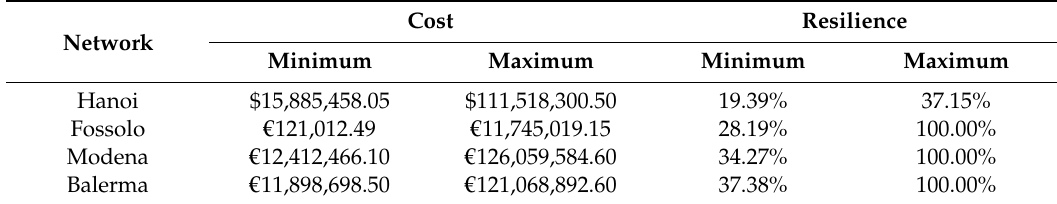
Table 3. Reference points used for the normalization of Pareto fronts (PFs). Cost Resilience Network Minimum